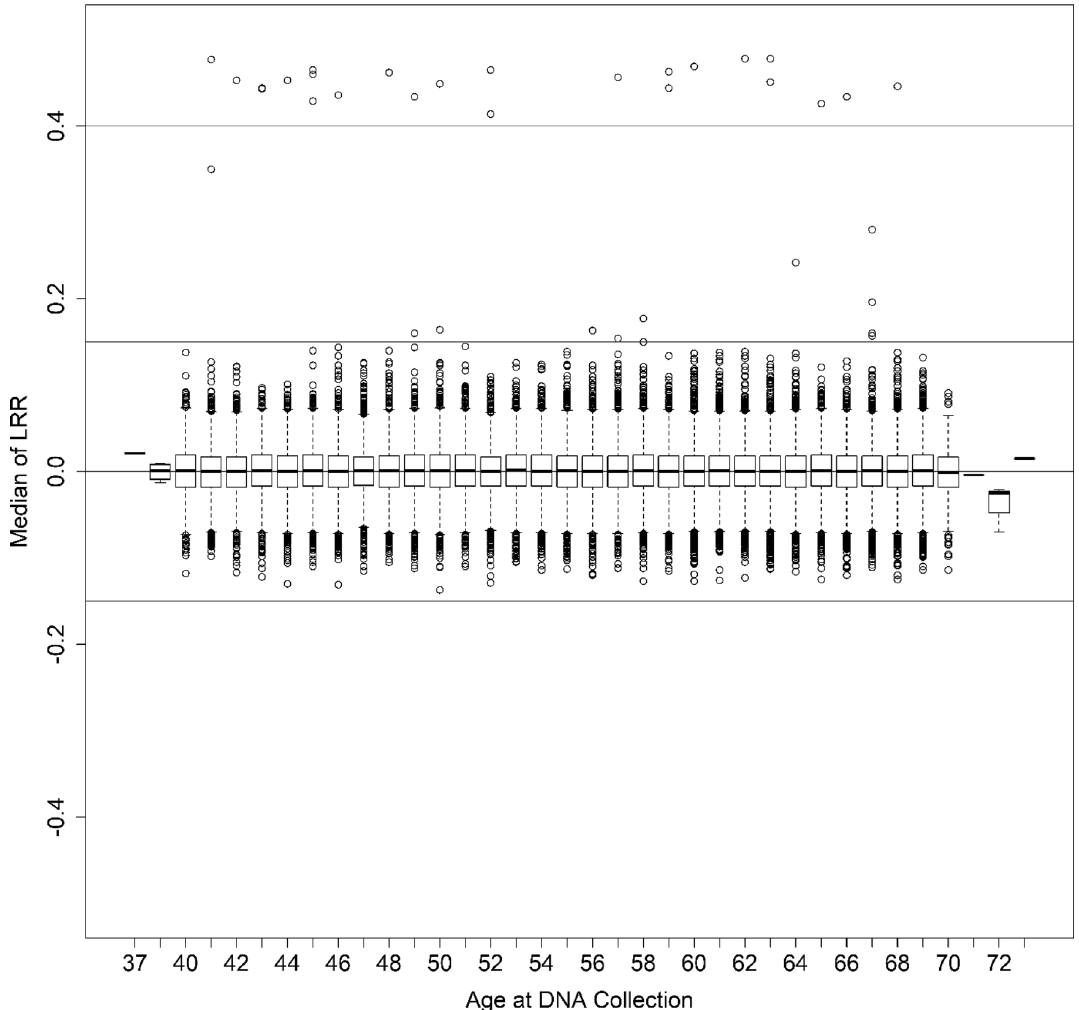
Figure 1. Boxplot of baseline corrected median chromosome X log 2 R ratio (LRR) at age of sample collection for 196,219 male UK Biobank participants. Distribution of baseline corrected median LRR is plotted by 1-year age groups. Male baseline corrected LRR values are centered around 0. Instances where baseline corrected median LRR ≥ |0.15| (blue lines) indicate evidence for chromosome X mosaicism. Participants with LRR ≥ 0.4 (green line) are constitutional XXY (Klinefelter